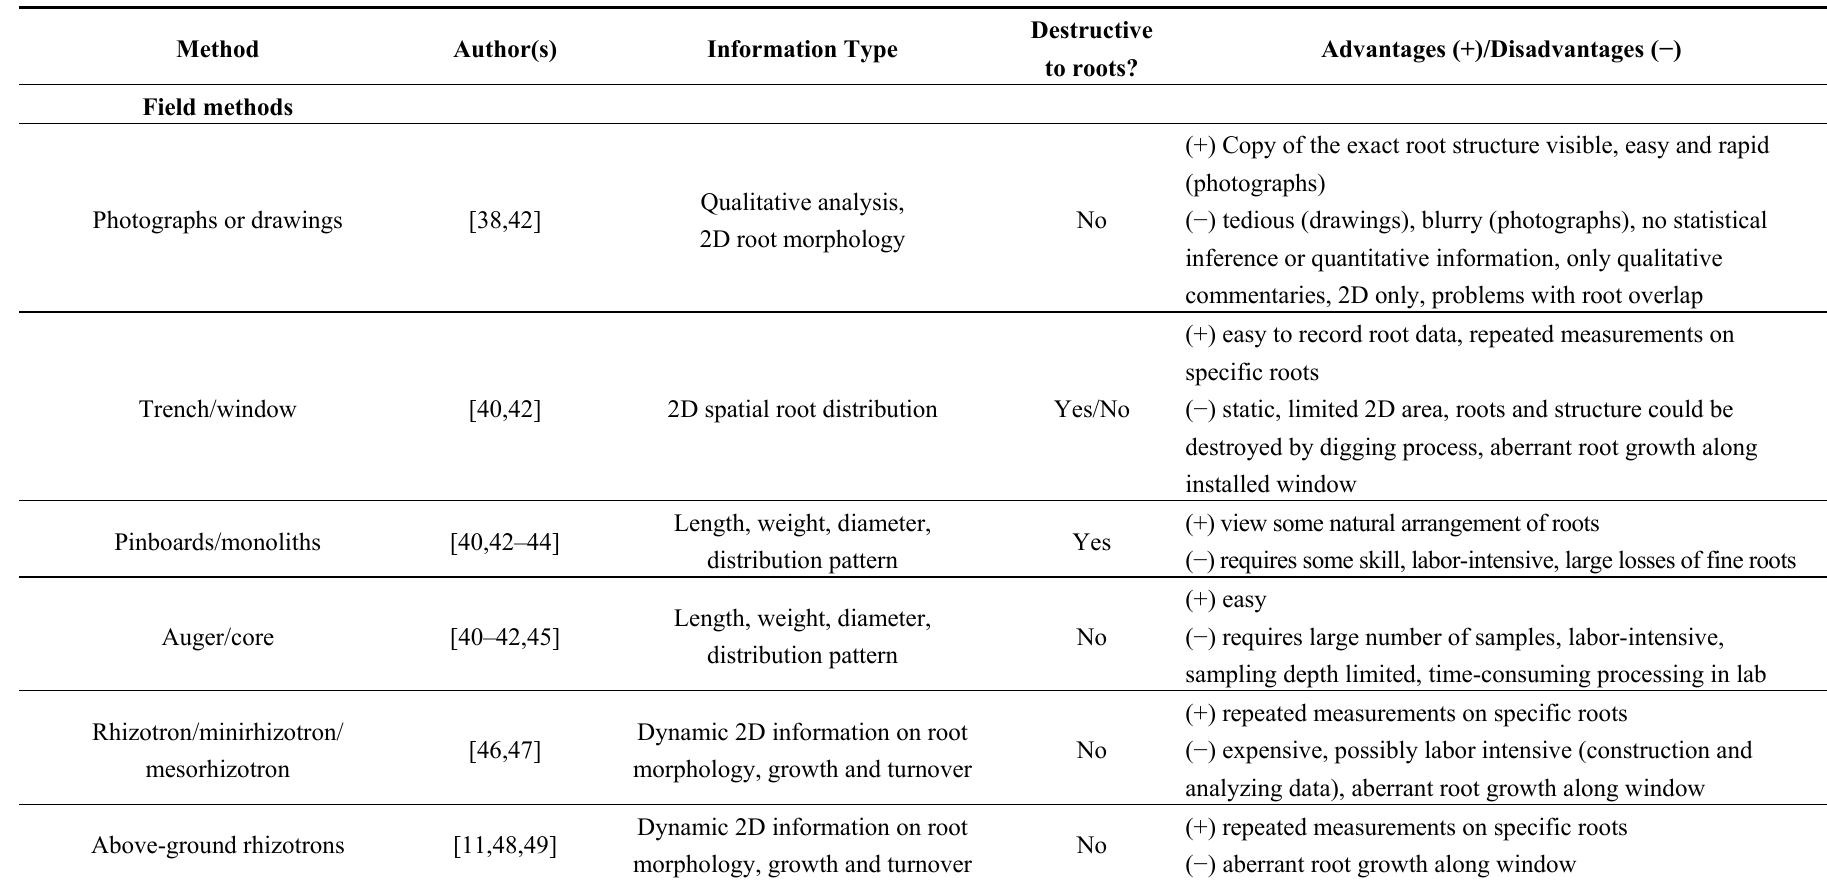
Table 1. Overview of most frequently used methods to measure or to analyze root systems, and selected studies reporting or using them. (Adapted from Reubens et al .